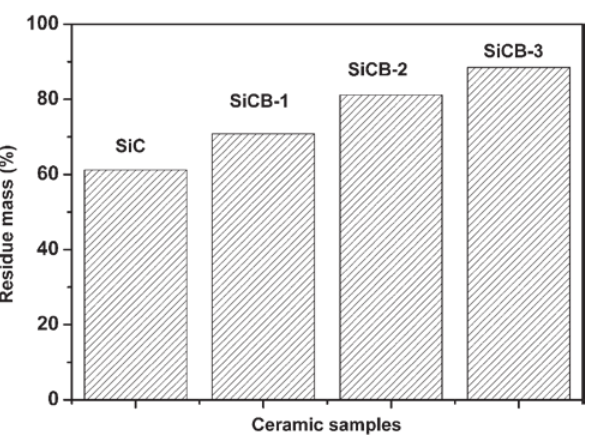
Fig. 10: Residue mass of ceramics annealed at 1800